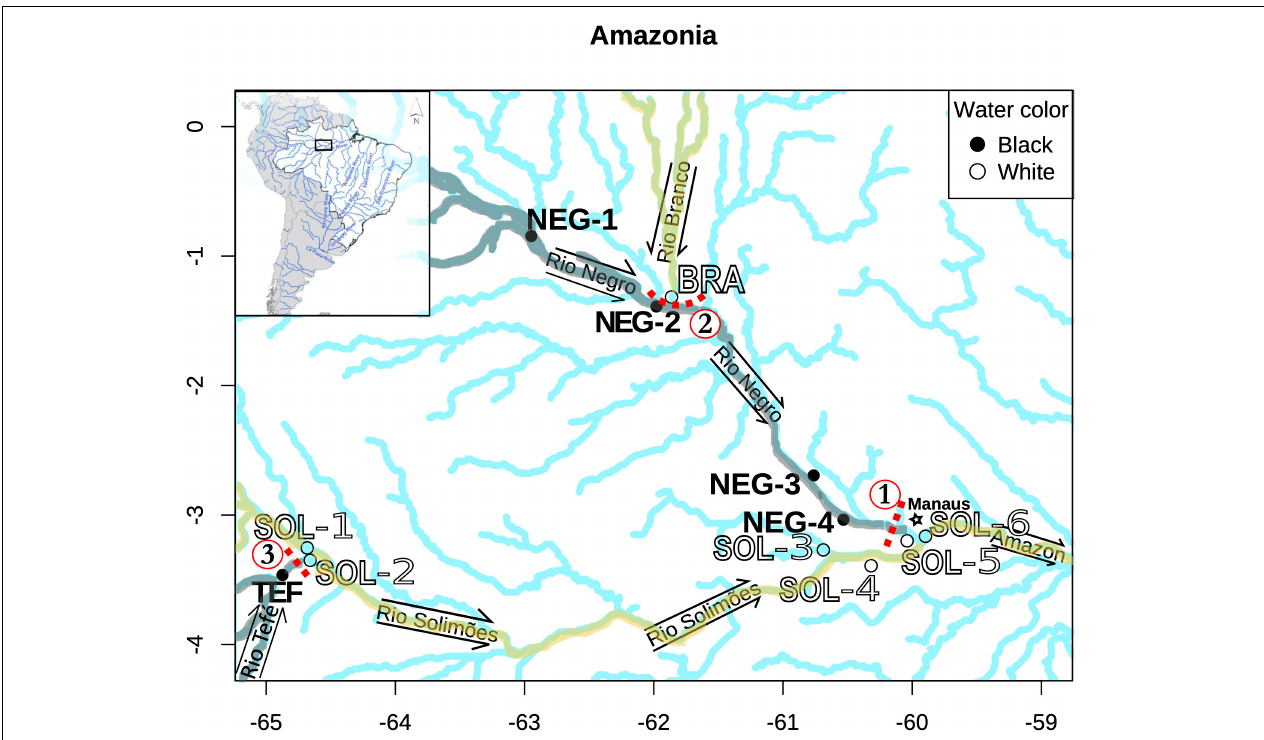
FIGURE 1 | Location of the sampling sites ( n = 12) in the Amazon basin. The four tributaries of the Amazon are labeled, and the water flow directions are identified using arrows. Rivers of interest have been highlighted according to their water type. Water is always flowing toward the East, in the direction of the Amazon. Sites have been identified using their river three letter acronym and numbered from the most upstream to downstream. Point colors are consistent with the described water type at a given site. The three genetic gaps detected in the study are also identified by red dotted lines and numbers (1–3). TABLE 1 | Expected percentage of heterozygosity (Hs), dissolved organic carbon (DOC), ionic composition (Na, Mg, K, Ca, and Cl), nutrient concentration (Silicate), productivity (Chlorophyll a : Chl a ), physiochemical characteristics (Conductivity: Cond and pH), total dissolved metal concentrations (Al and Fe), and Global